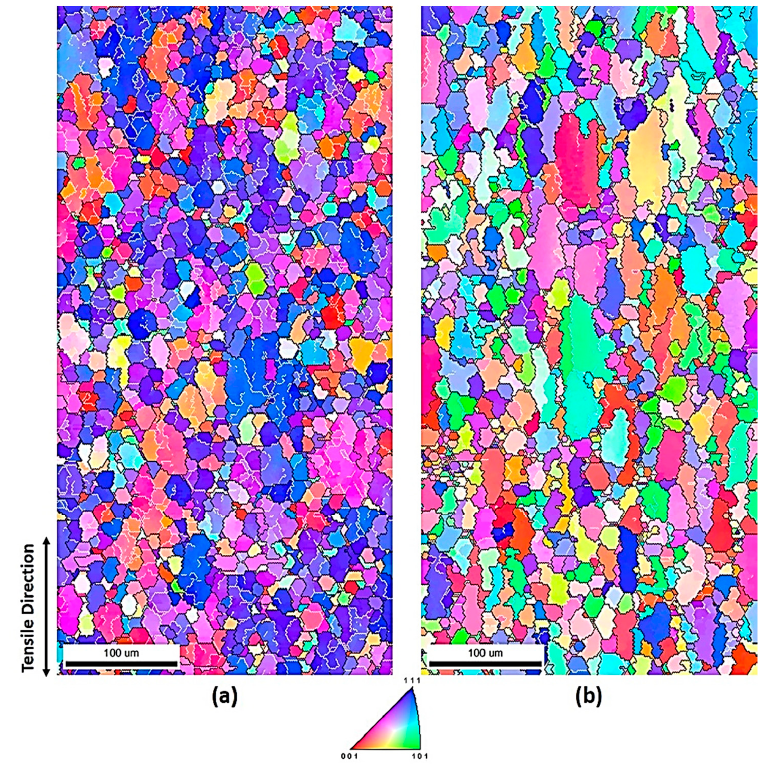
Figure 6. EBSD inverse pole figure (IPF) maps of samples processed in a die with a temperature of 350 °C upon hot tensile tests at the strain rate of 0.01 s − 1 and temperature of ( a ) 200 °C and ( b ) 400 °C.